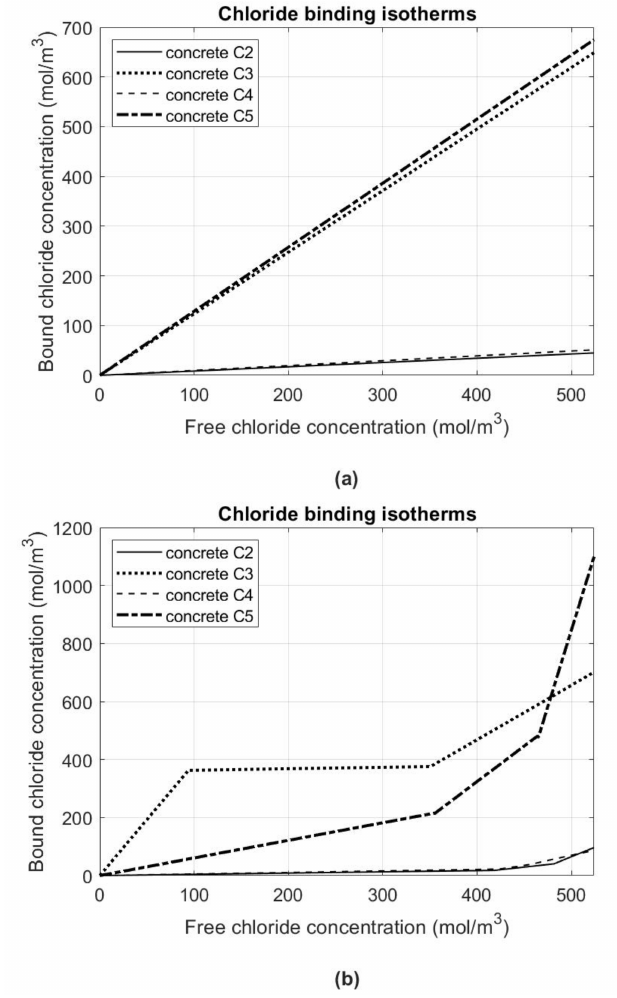
Figure 4. Chloride binding isotherms for concretes C2–C5 based on the results presented in: ( a ) Table 5 for the linear approximation, ( b ) Table 7 for the approximation with spline